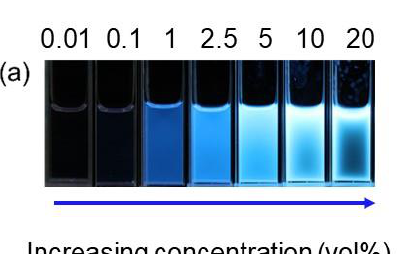
5 of 14 Figure 2. ( a ) Photographs of imines 2-6 ethanol solutions (5 vol.%) under 365 nm UV light, and ( b ) photographs of imine 1 solid powders under daylight and 365 nm UV light. ( c ) Fluorescence emis- sion spectra of pure imines 2-6 in liquid state, and ( d ) their maximum excitation wavelength (black) and maximum emission wavelength (red). The fluorescence excitation and emission spectra of the ethanol solutions of imines 2 - 6 with different concentrations were also measured. The imines show an intriguing con- centration-dependent emission (CDE). Generally, with an increase in concentration, the photoluminescence (PL) intensity increases, and the  exmax and  emmax also red-shift (Fig- ure 3). It is worth noting that, for the imines 2 , 3, and 5 , their  emmax keep almost constant firstly; however, an abrupt red-shift of  emmax is observed when the concentration is in- creased to a certain value. For example, the  emmax of the imine 2 solution is at 397 nm when the concentration is lower than 5 vol.%; however, it is increased to 457 nm when the con- centration is more than 10 vol.%. While, for the imines 4 and 6 , their  emmax slightly red- shifts or even remains constant with an increase in concentration. The appearance of two main  emmax at different concentrations suggests the presence of two or more chromo- phores and the mutation of the chromophores with a change in concentration. This is fur- ther evidence of the aggregation of imine molecules and the formation of TSC among them. It is also necessary to note that, at low concentrations, the PL intensity of the solutions of imines 2 and 5 firstly increases quickly and then remains constant or even decreases with increasing concentration; however, when the concentration is further increased, the  emmax red-shifts to a higher value and the PL intensity increases with increasing concentration. This abnormal phenomenon can also be explained with the transformation of chromo-